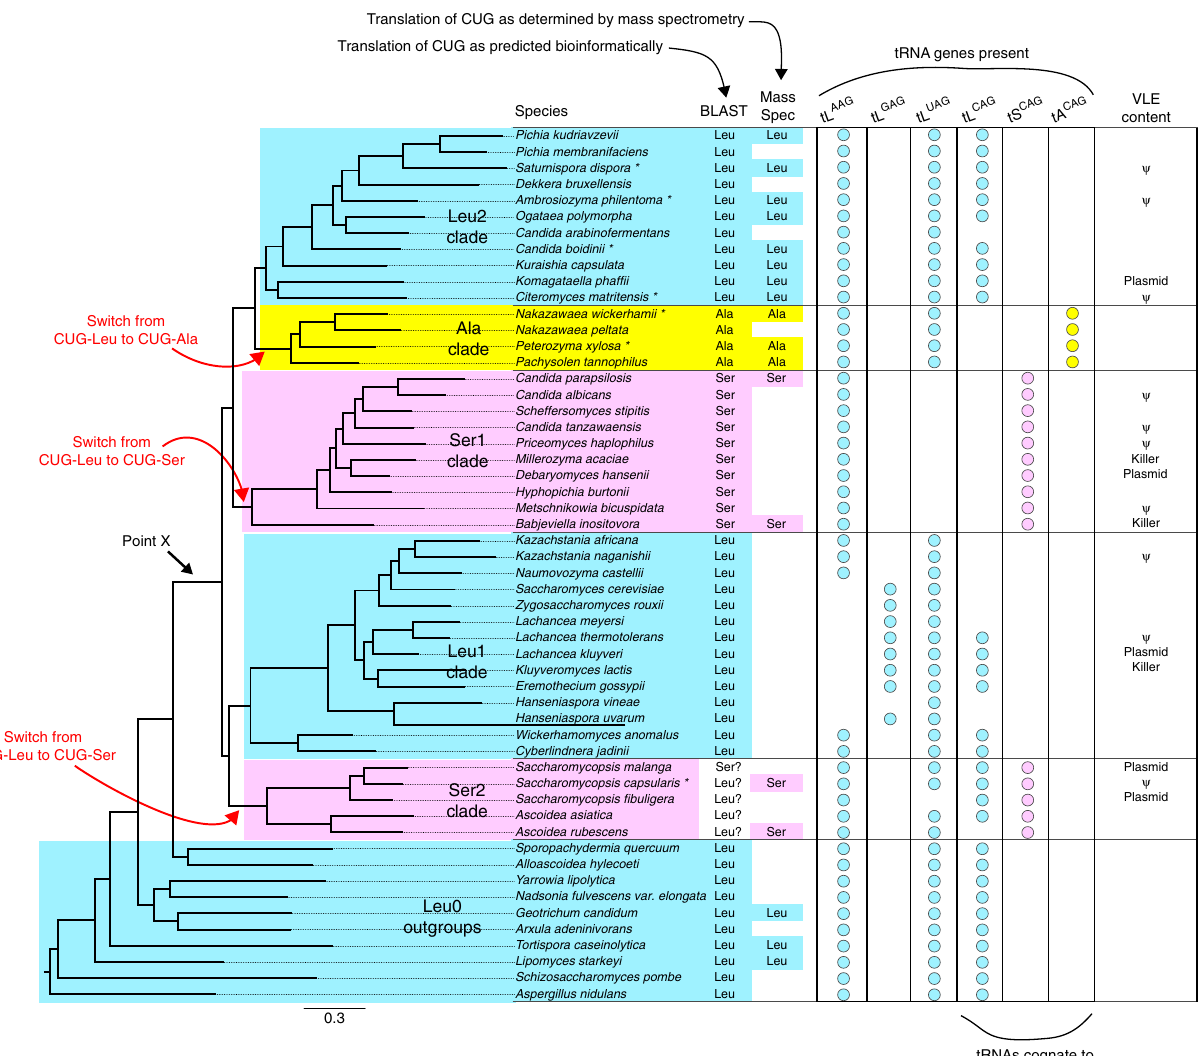
Fig. 2 Phylogenomic tree and CUG decoding in 52 yeast species. Blue, pink and yellow indicate CUG translation as Leu, Ser, and Ala, respectively. Point X indicates the last common ancestor of the clades with altered genetic codes. Circles indicate the presence of tRNA genes with the indicated anticodons. The VLE content column shows species where a characterized Virus-Like Element with killer activity is present (Killer), a VLE-like plasmid is present but killer activity has not been demonstrated (Plasmid), or VLE-like pseudogenes are present in the nuclear genome ( ψ ). Asterisks beside species names indicate genomes sequenced in this study. The tree was constructed from 1237 proteins by maximum